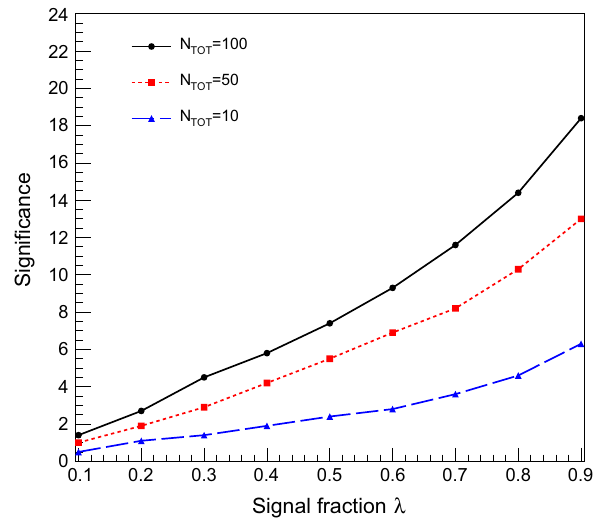
Fig. 5 Mean significance as a function of the expected WIMP fraction λ for N = 10 (black solid line), 50 (red dotted line), 100 (blue dashed line). A 40 GeV/c 2 WIMP mass is assumed